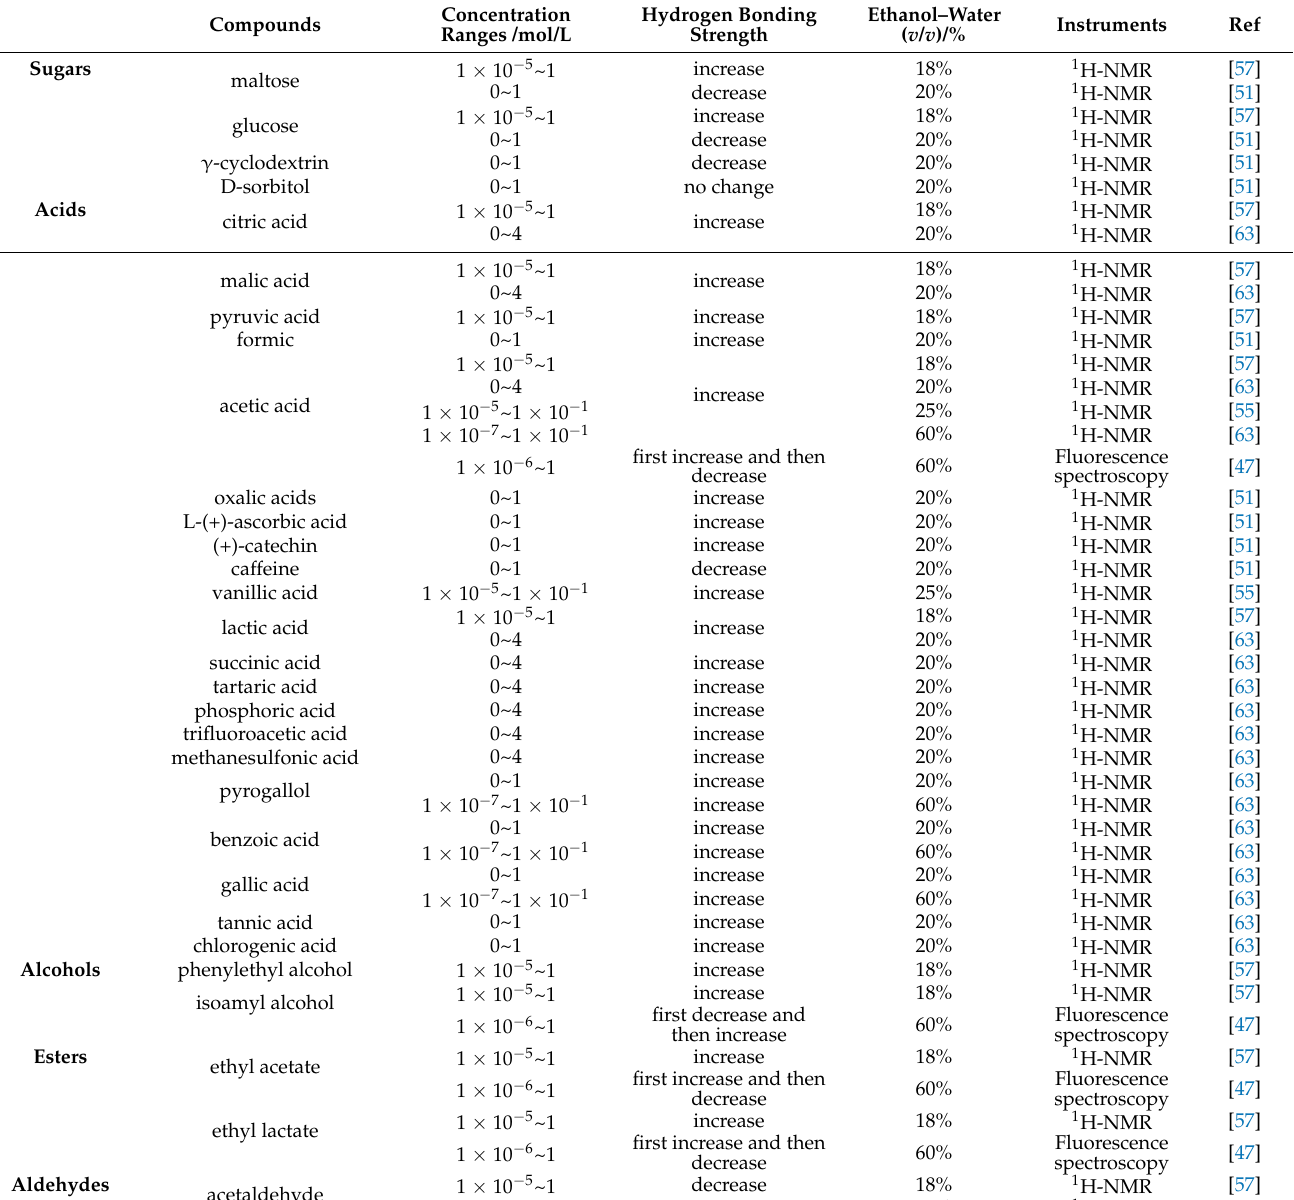
Table 1. Effect factors of hydrogen bonding strength in different ethanol–water systems (From Refs. [47,50,51,55,57,62,63]).